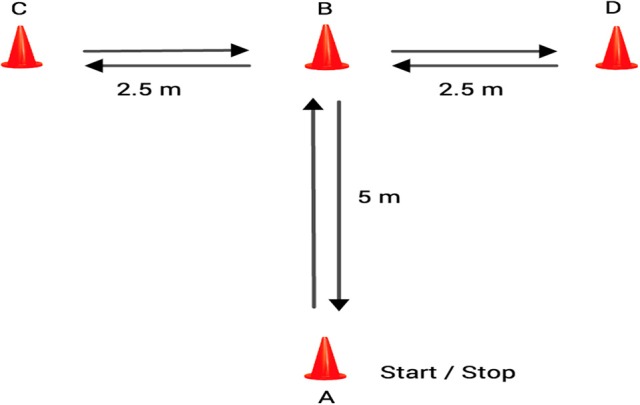
Modified agility T-test.